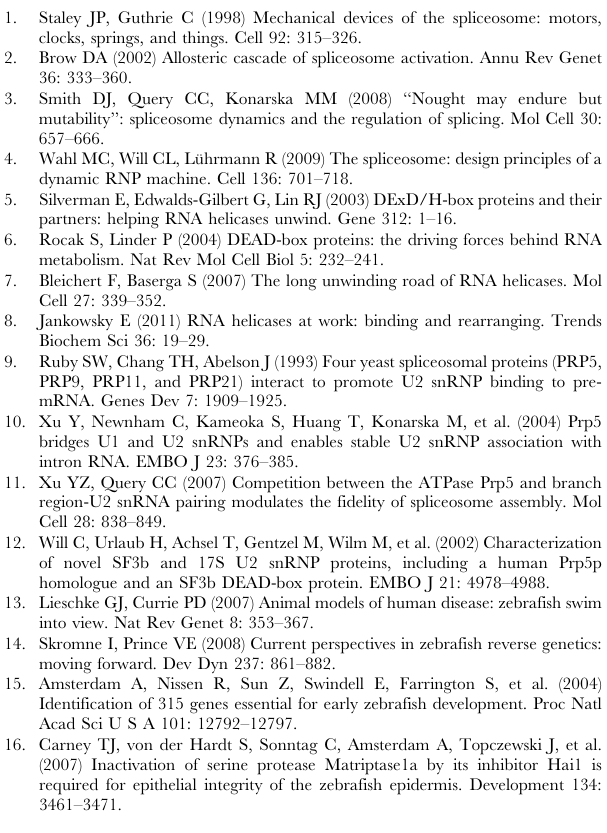
Table S1 The list and sequence of primers used for RT-PCR analysis. Table S2 PCR thermal cycler program for